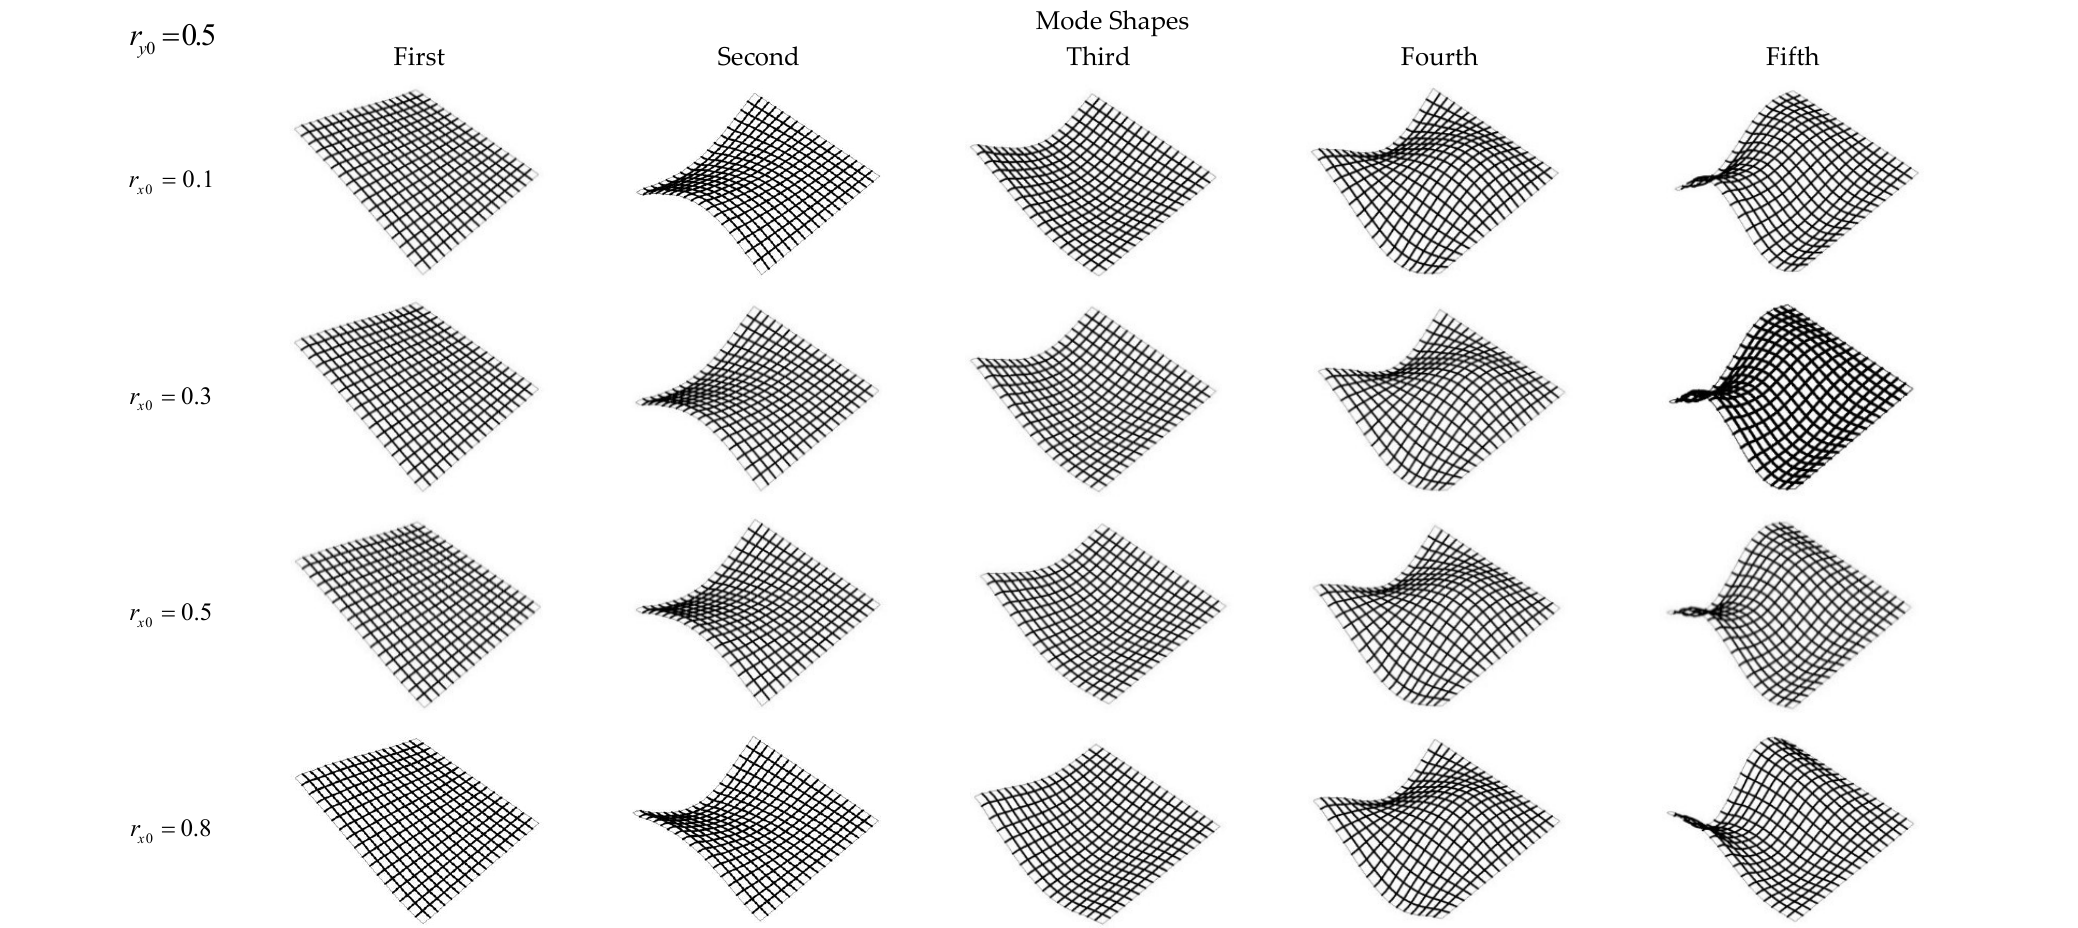
Figure 5. First five mode shapes of the RRFF square plates